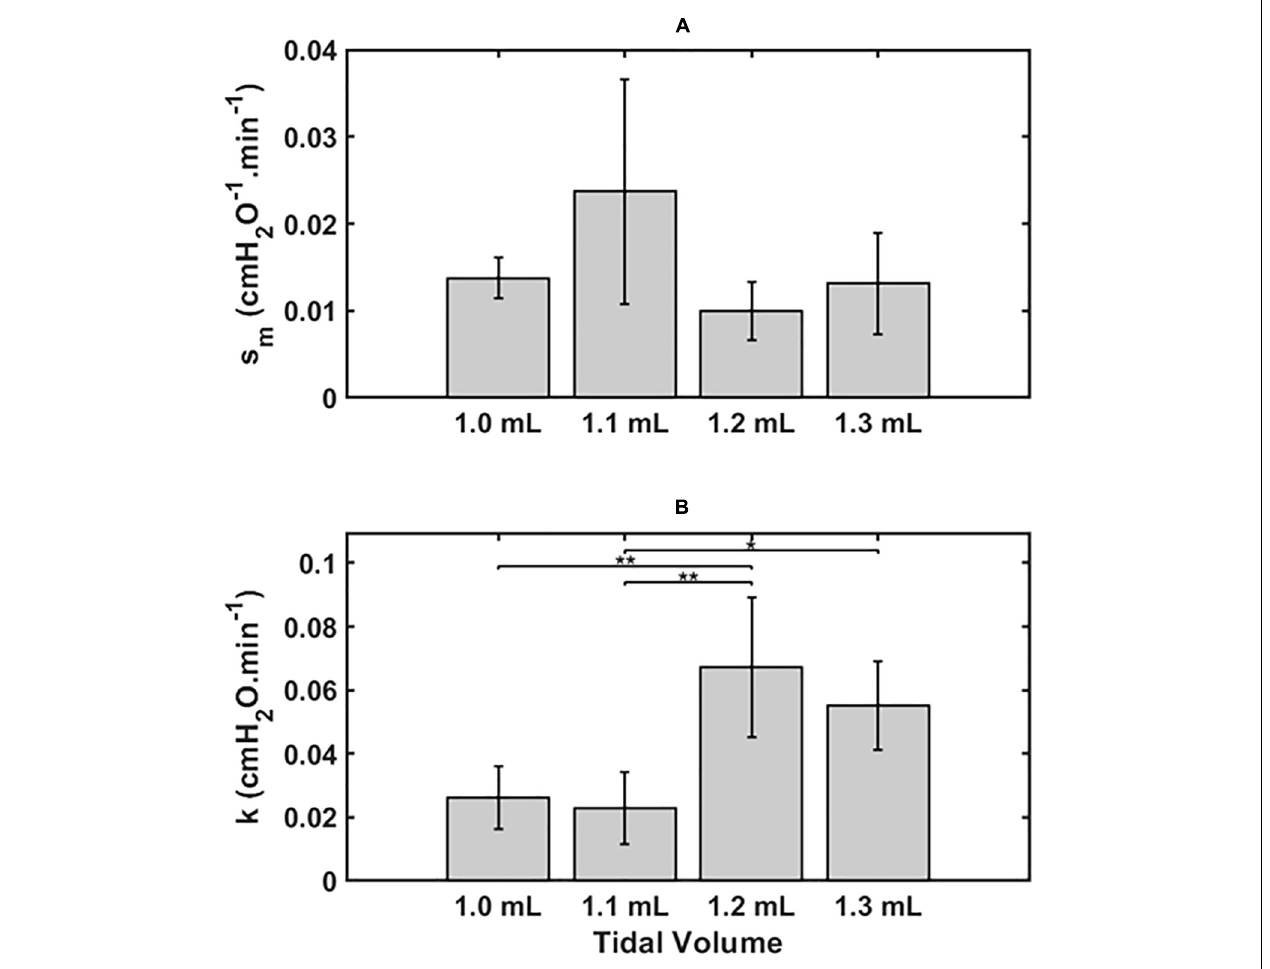
FIGURE 2 | Mean ± 2 SEM for the two key model parameters s m (A) and k (B) and for the 4 groups, 1.0 ml ( n = 6), 1.1 ml ( n = 6), 1.2 ml ( n = 5) and 1.3 ml ( n = 4). Statistically significant differences between groups are indicated by: * P < 0.05), ** P <